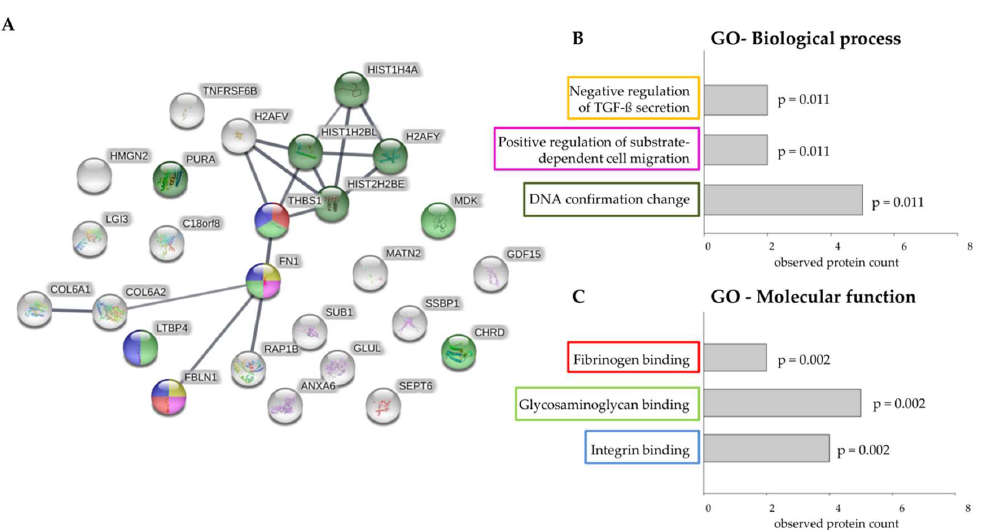
Figure 7. Prediction of protein interactions between upregulated proteins and functional enrichment analysis. ( A ) Protein interaction map of upregulated proteins identified in TGFBR2-deficient EVs (generated by STRING (v11.0)). The connecting lines between protein nodes represent protein-protein interactions. Line thickness indicates the strength of data support (minimum required interaction score = 0.700, high confidence). Coloring of proteins is based on functional enrichment analysis. ( B ) and ( C ) Visible clusters of the protein-protein interaction map were assigned to enriched ontologies for Biological Processes ( B ) and Molecular Function ( C ). Graphs showing most significant enriched Gene Ontology (GO) among the upregulated EV proteins with observed protein count for each category and calculated p -value adjusted for multiple comparisons.